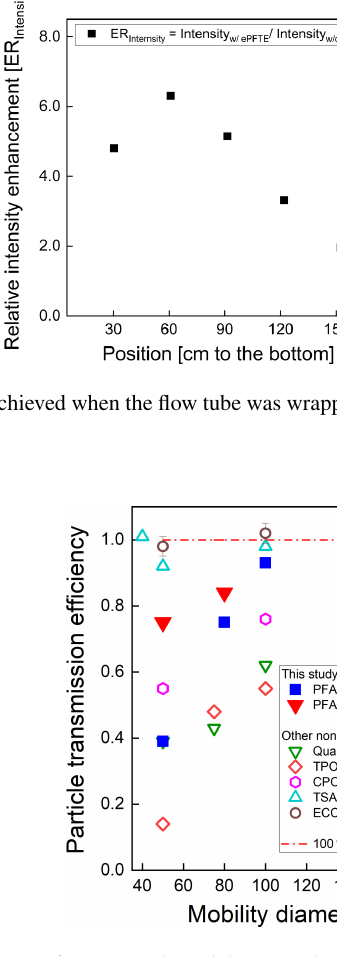
Figure 6. Measured particle transmission efficiency of the PFA OFR, quartz PAM and TPOT (Lambe et al., 2011), CPOT (Huang et al., 2017), TSAR (Simonen et al., 2017), and ECCC-OFR (Li et al., 2019) flow reactors as a function of mobility diameter for bis(2-ethylhexyl) sebacate (BES) and ammonium sulfate (AS). Our results are shown as blue squares and red